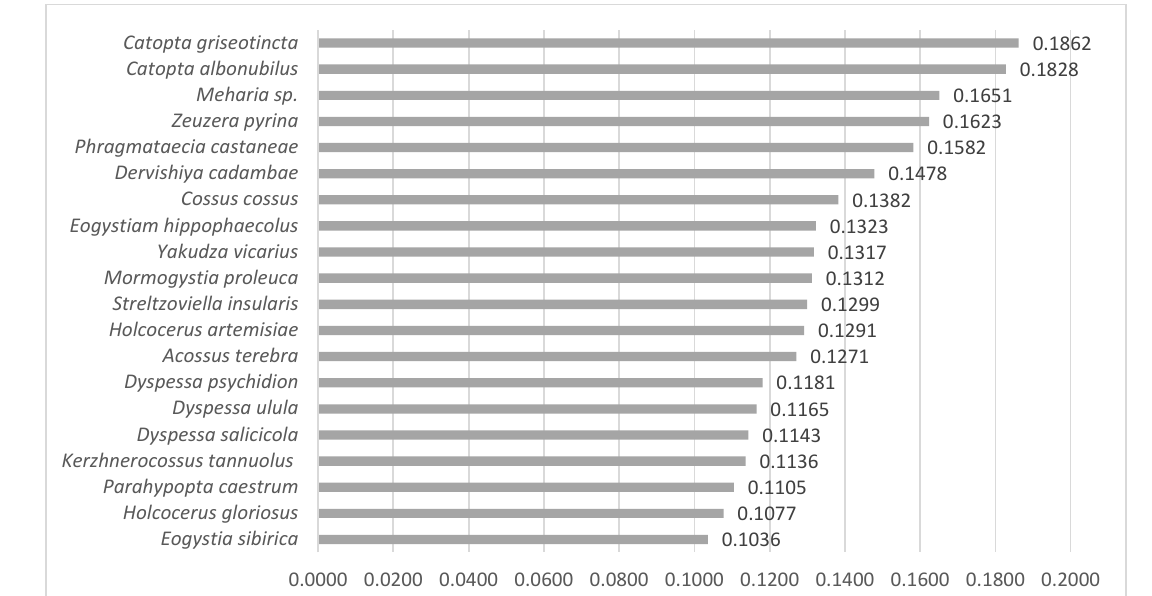
Figure 9. The average values of the genetic distances of the analyzed species towards the P. thrips species.